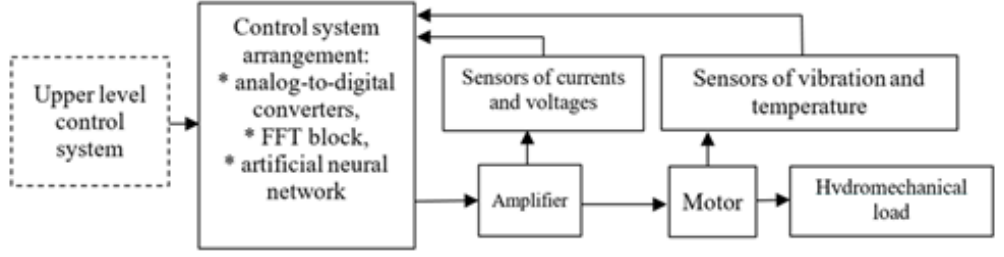
Figure 6. Functional diagram of the EDP electric motor control, monitoring and diagnostic